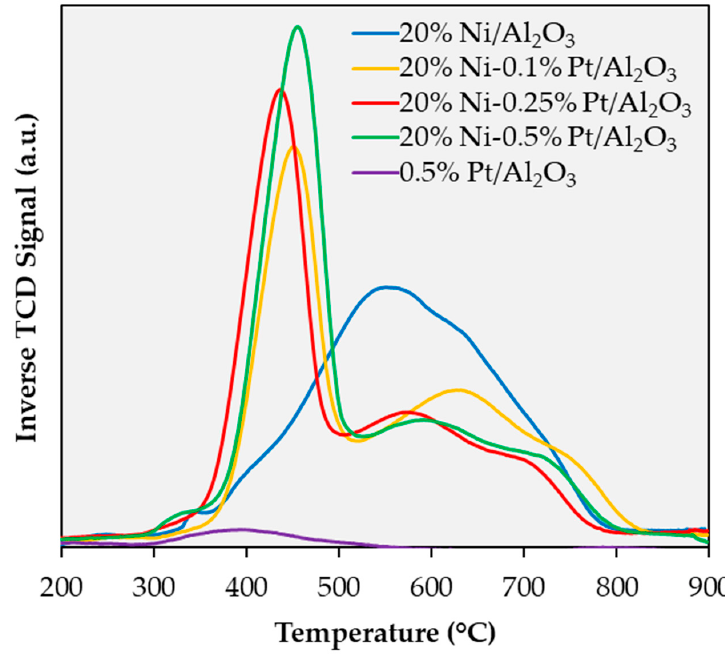
Figure 3. Temperature programmed reduction profiles of the catalysts studied.